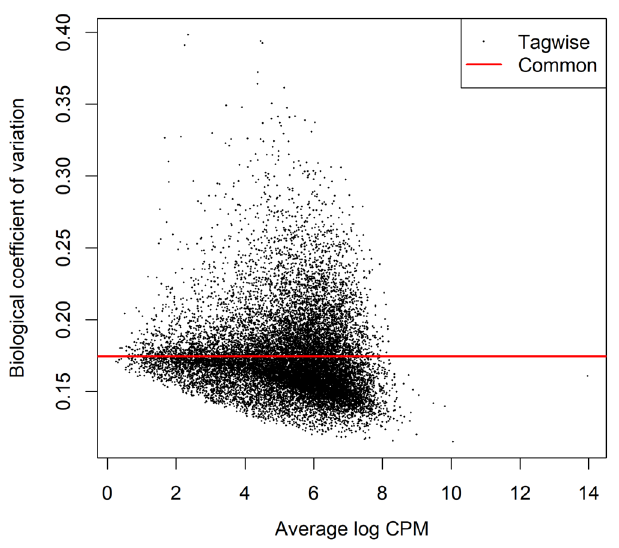
Figure 6. Scatterplot of the biological coefficient of variation (BCV) against the average abundance of each gene. The plot shows the square-root estimates of the common and tagwise NB